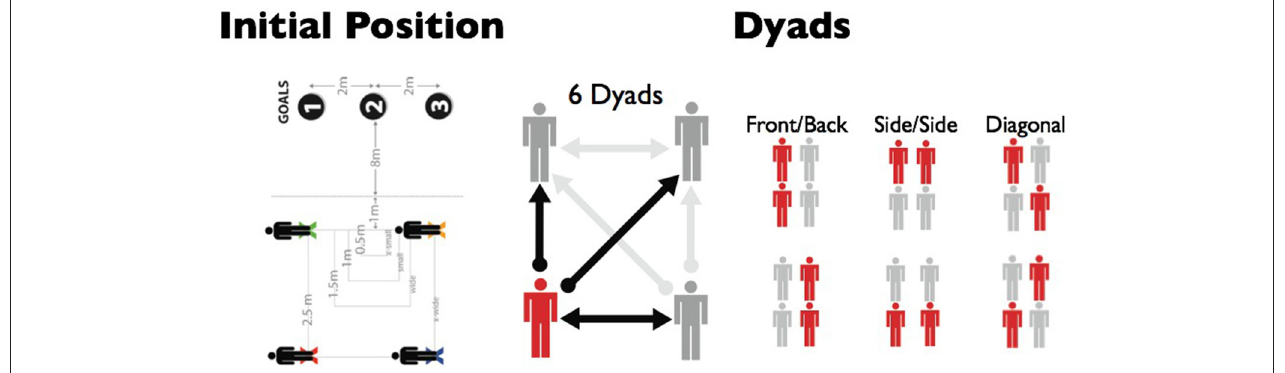
FIGURE 1 | The four possible starting positions for each of the four possible starting densities (left). Note the dotted “trigger” line 1m from the midpoint between the front two participants that represents when the experimenter “goal” command was given. The visual couplings of the six possible dyads (center) with double arrows indicating bi-directional vs. unidirectional (single arrow) coupling. The six dyads are highlighted in the right pane.